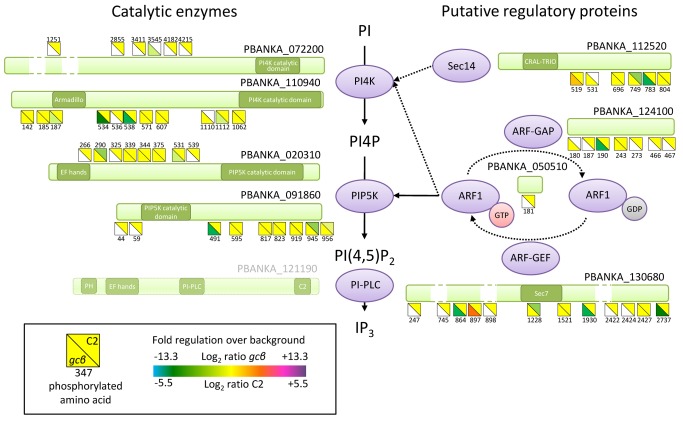
Phosphorylation sites in proteins with likely roles in phosphoinositide metabolism.All class I phosphorylation sites are shown as squares next to the schematic illustrations of the relevant proteins and their annotated functional domains. PI-PLC was not detected and is shown in light green. Each phosphorylation site is represented by a divided square, the colour of which shows the degree of regulation upon inhibition of PKG by C2 or in the gcβ mutant. Failure to quantify a phosphorylation site with one of the two experimental designs is shown in white.